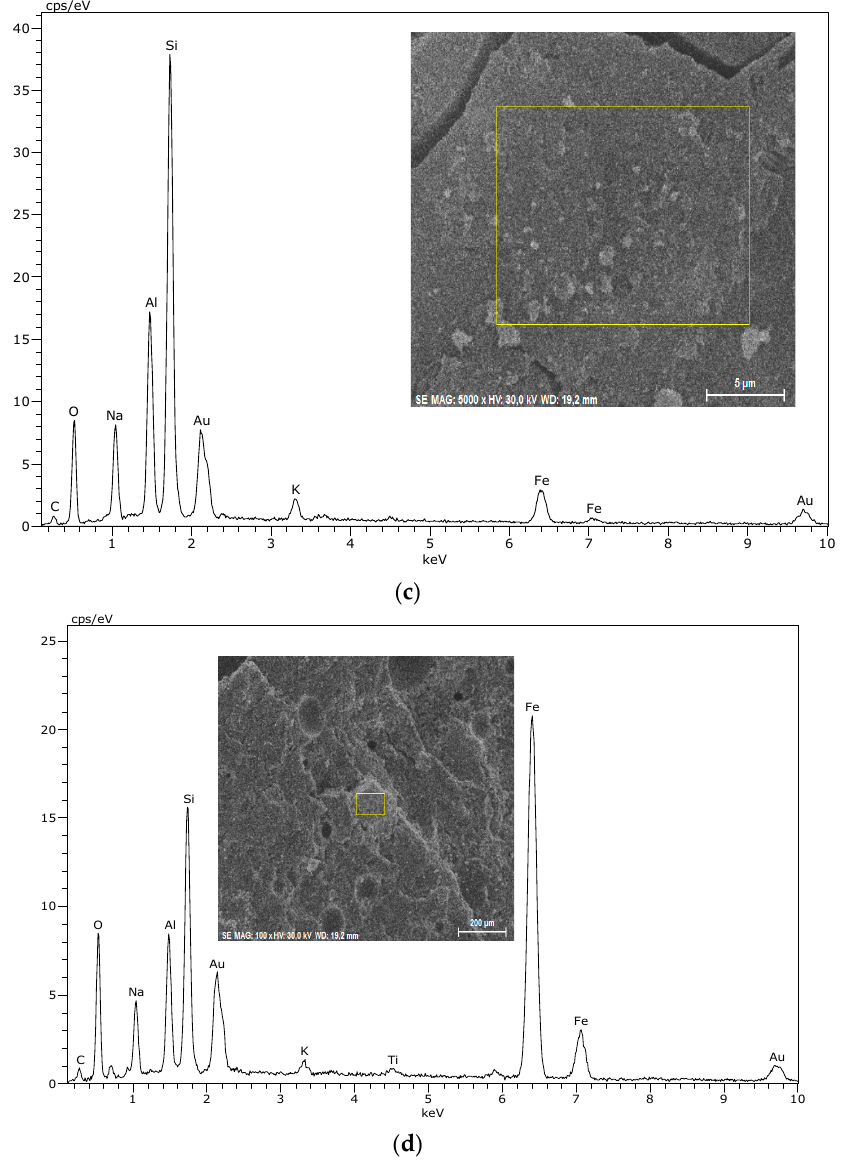
Figure 14. EDS spectra of areas of samples G0 ( a ), GR10 ( b ) and GR20 ( c ) as indicated in the inserted micrographs by the red rectangles (taken with magnification 5000×). With an average of quantification of 5, such areas of each sample are given in Table 3. ( d ) EDS spectrum of GR20 taken at a magnification of 100 × and focused on a smaller area with a higher iron content, suggesting a localization of hematite. Table 2. Chemical composition from EDS analysis (Atom%, average of 5 fixed areas using magnification 5000×).